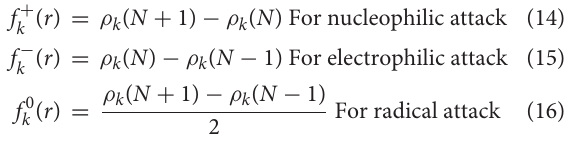
TABLE 1 | Calculated quantum chemical parameters for three thiophene derivatives in gas phase (all in eV). E HOMO E